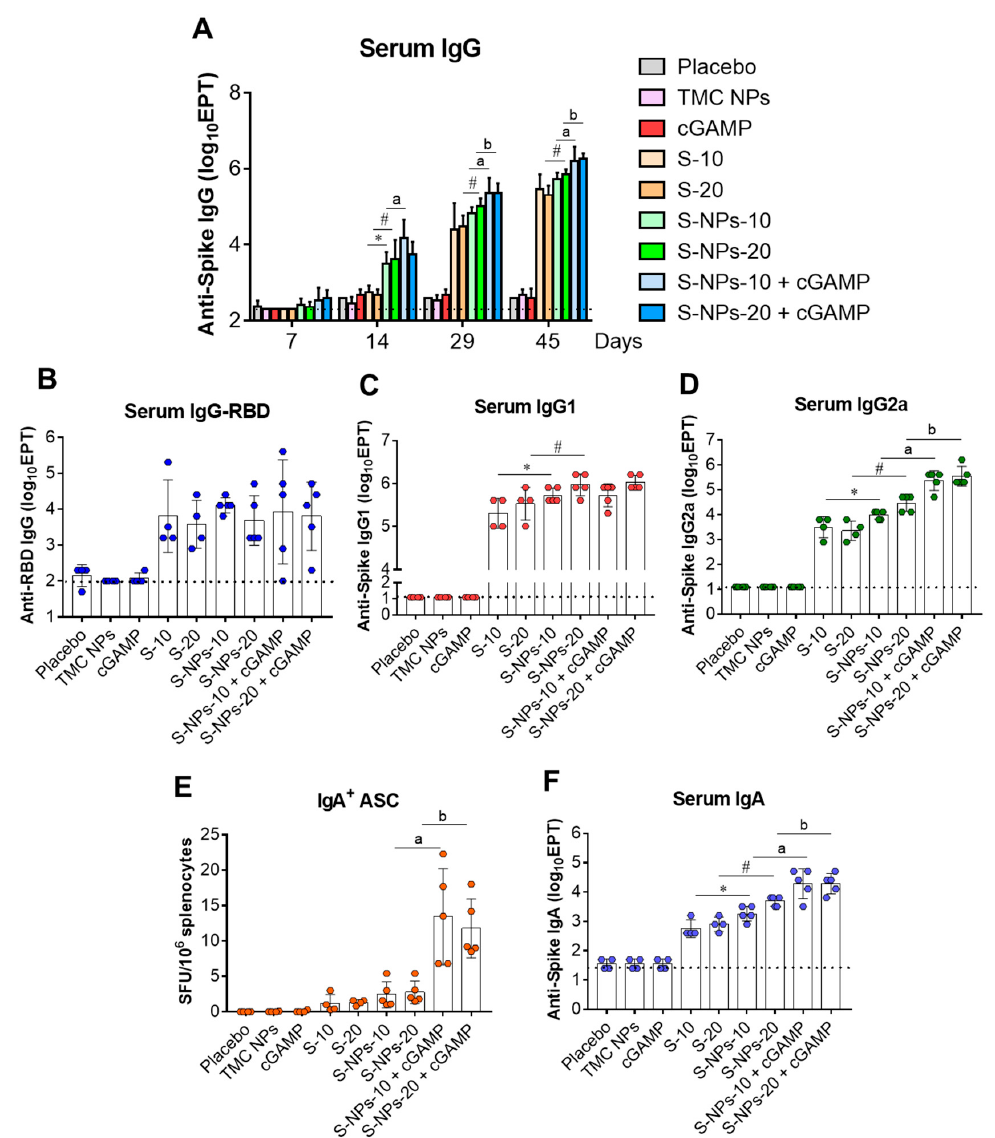
Figure 4. Systemic antibody responses induced by soluble S-protein, S-NPs, or S-NPs + cGAMP. Mice were administered intranasally with a four-dose regimen of soluble S-protein (S), S-NPs, or S-NPs + cGAMP at 10 or 20 μ g/dose. Sera collected from immunized mice on days 7, 14, 29, and 45 were analyzed for S-IgG ELISA assay ( A ). IgG titers against RBD protein ( B ), S-IgG1 ( C ), and S-IgG2a ( D ) in sera on day 45 were determined by indirect ELISA. Frequencies of S-specific IgA + B cells in spleen were enumerated by ELISPOT ( E ). Levels of IgA in immunized sera on day 45 were quantitated by indirect ELISA ( F ). Data are presented as mean ± SD. * and # indicate significant differences between soluble S-protein and S-NPs at 10 and 20 μ g/dose, respectively. “a” and “b” indicate significant differences between S-NPs and S-NPs + cGAMP at 10 and 20 μ g/dose, respectively ( p < 0.05). Dotted line indicates LoD of the assay.